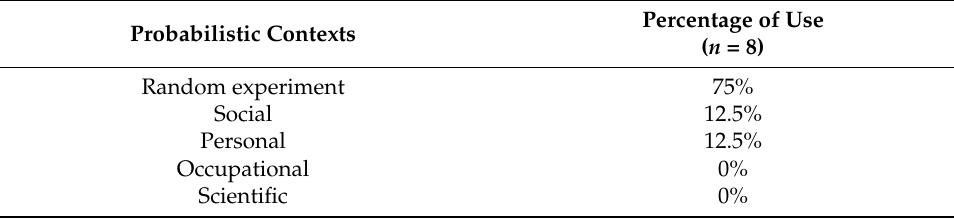
Table 5. Tasks’ probabilistic contexts.